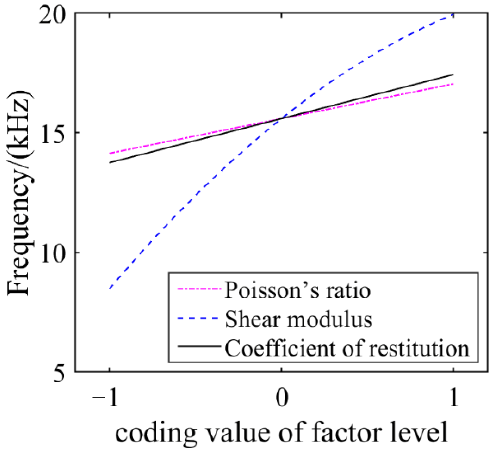
Figure 7. Curves of various factors on the dominant frequency.